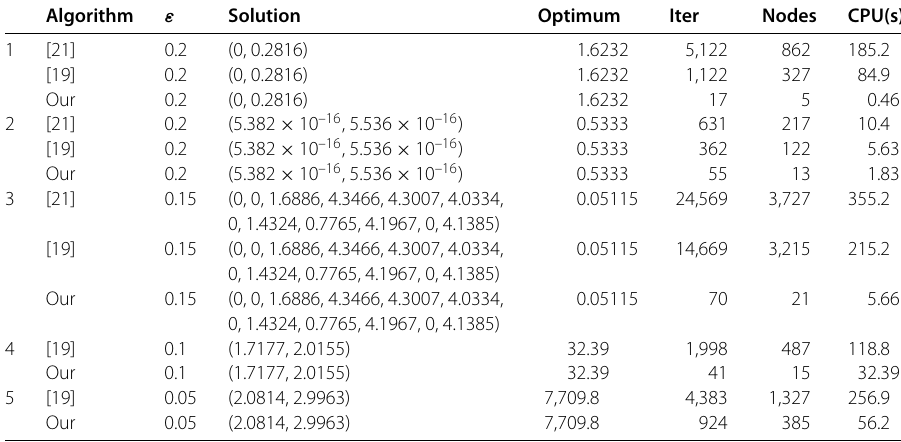
Table 1 Computational results of Examples